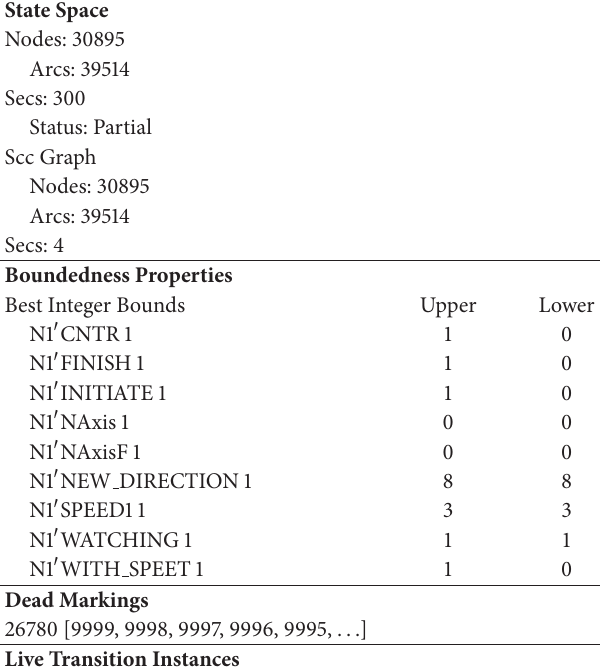
Table 4: Statistics for